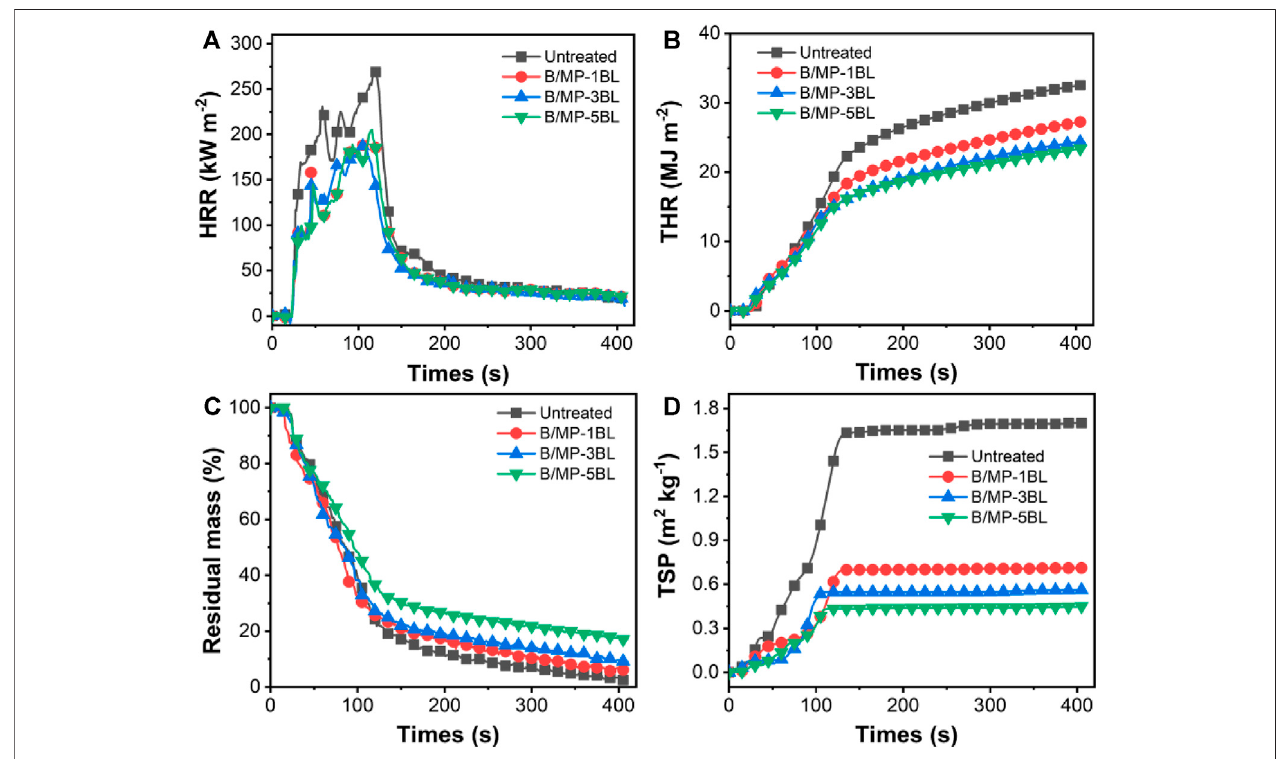
FIGURE 6 | Cone calorimetry tests of untreated and treated bamboo with different times of the cycle: HRR (A) , THR (B) , residual mass (C) , and TSP (D) .